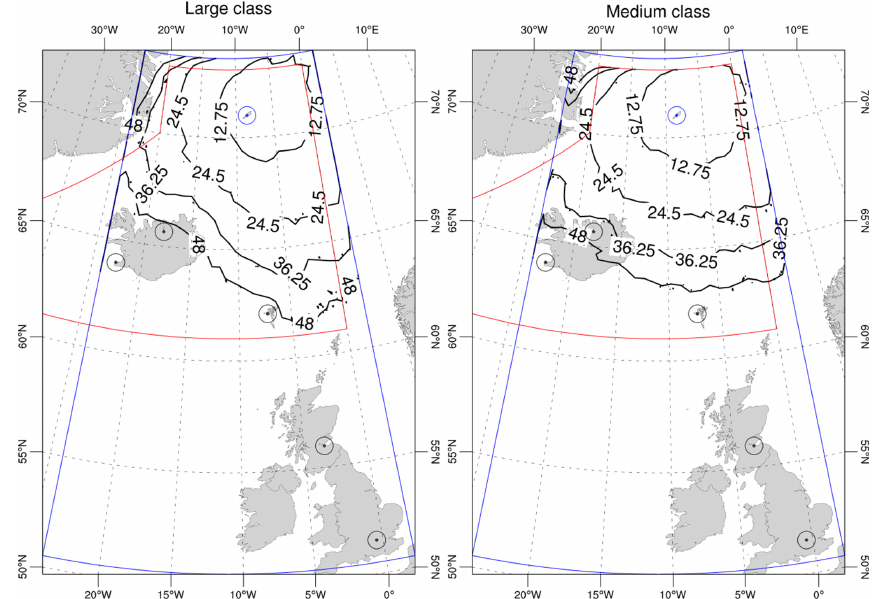
Figure 8. The isolines show the arrival time in hours required for the ash concentration (at FL050) to exceed a threshold of 2mgm − 3 with an exceedance probability of 5% between 0 and 48h after the eruption. Black circles correspond to Keflavik and Akureyri (Iceland), Vágar (Faroe Islands), Edinburgh (Scotland), and Heathrow (London, UK) airports.